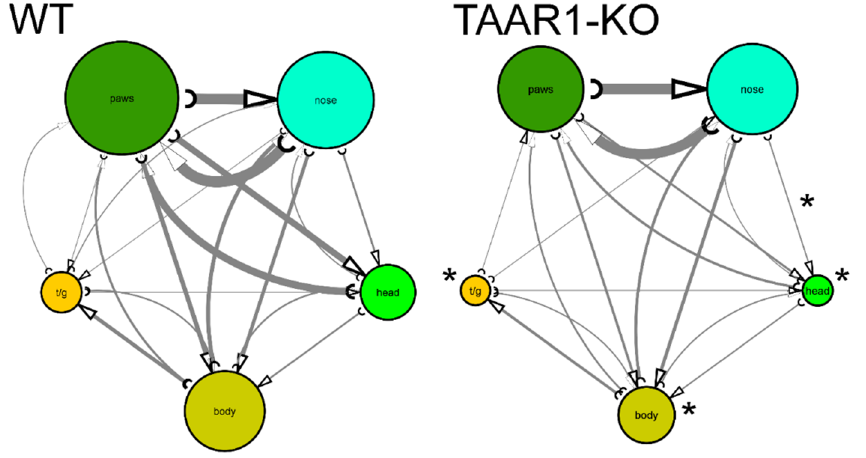
Figure 4. Comparative self-grooming microstructure analyses of TAAR1 knockout (KO) mice vs. wild type (WT) control group in the grooming test (n = 14 per group). The diameter of circles and line thickness reflect mean frequency of grooming bouts or transitions, respectively. All grooming bouts, but only ‘correct’ grooming transitions adhering to the cephalo-caudal progression (paws > face > head > body > tail/genitals) were statistically assessed. * p < 0.05 vs. control, Mann–Whitney U-test. WT—wild type control mice.